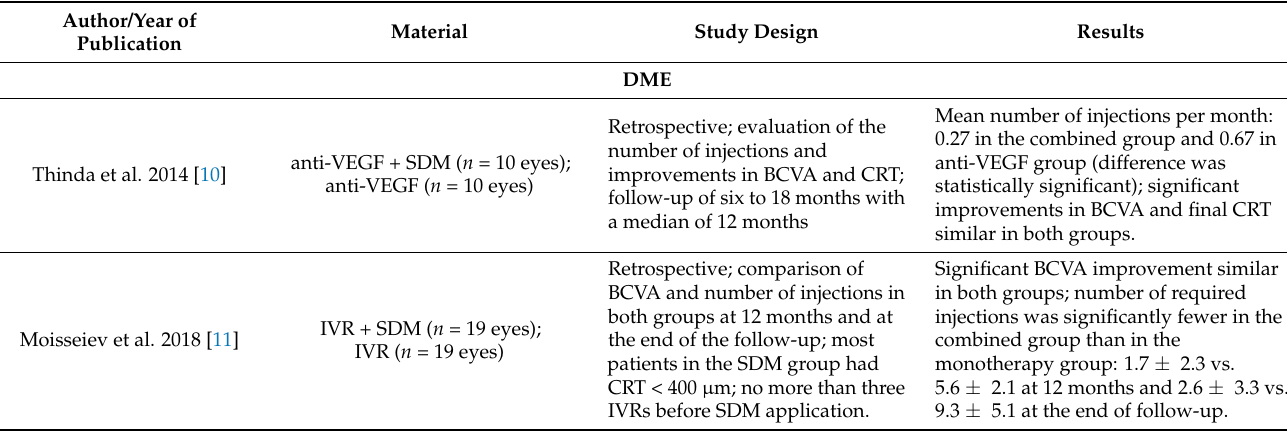
Table 1. Studies that compared combined SDM and anti-VEGF/intravitreal steroid therapy and intravitreal treatment alone in the management of retinal